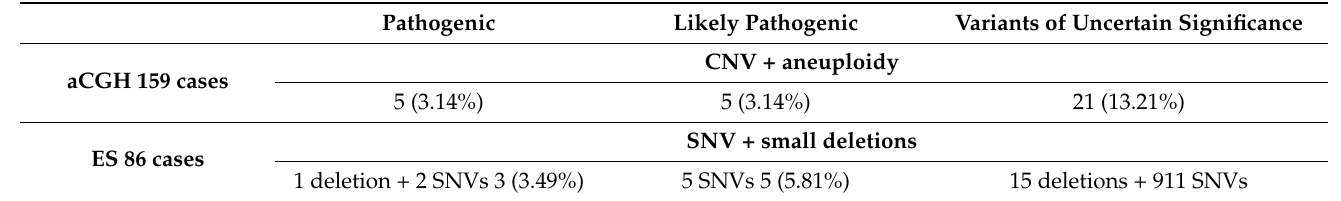
Table 5. Pathogenic, likely pathogenic, and variants of uncertain significance identified by array and exome sequencing. For the likely pathogenic variants, only CNVs and SNVs which correlated with the patient phenotypes have been